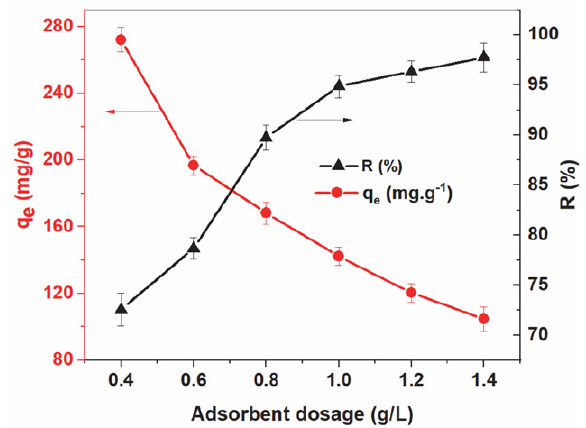
Fig. 4. SA-RPB dosage effects on equilibrium adsorption capacity ( q e , mg/g) and removal efficiency of MB ( R , % ) (The tests conducted for 105 min by 150 mg/L MB at 6.5 pH)